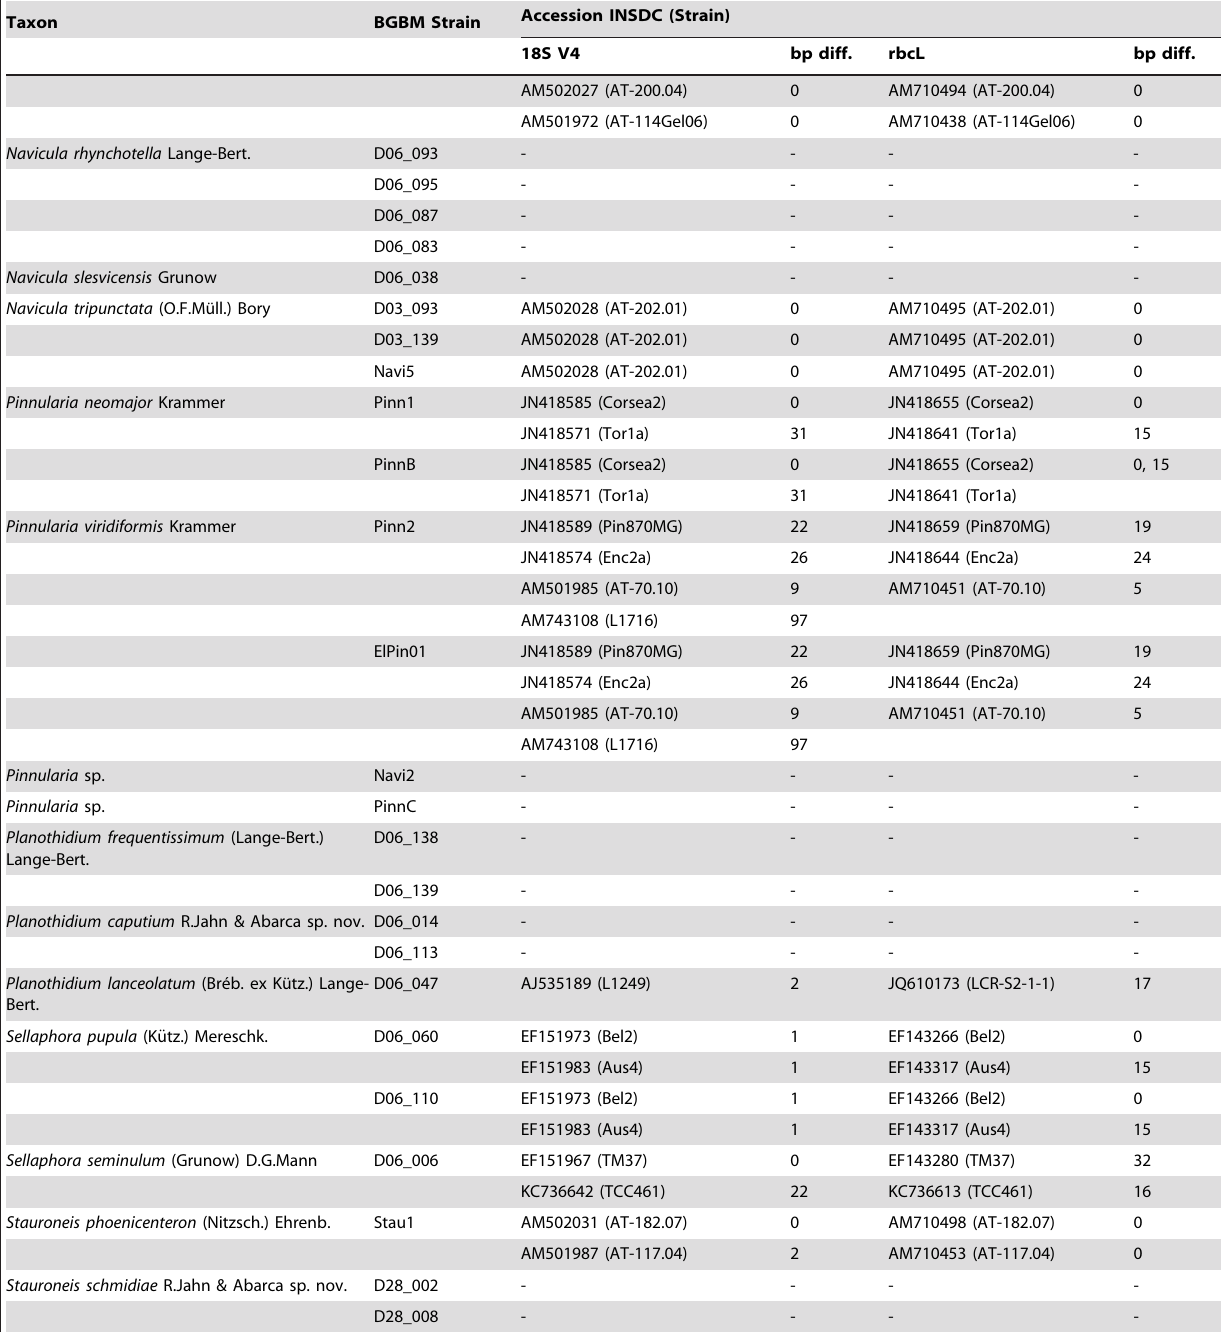
Basepair differences (bp diff.) for each taxon and strain number specified for both markers 18S V4 and rbc L. – denotes missing representative for taxon in INSDC databases (accessed July